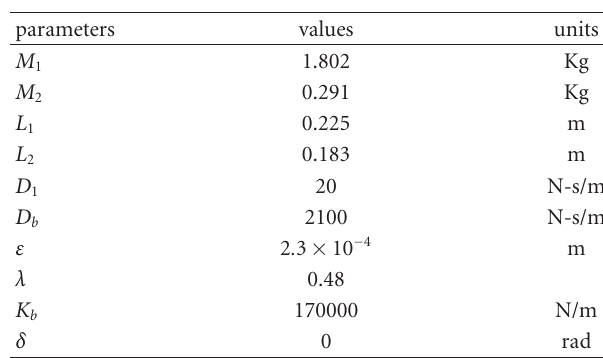
Table 1: Simulation